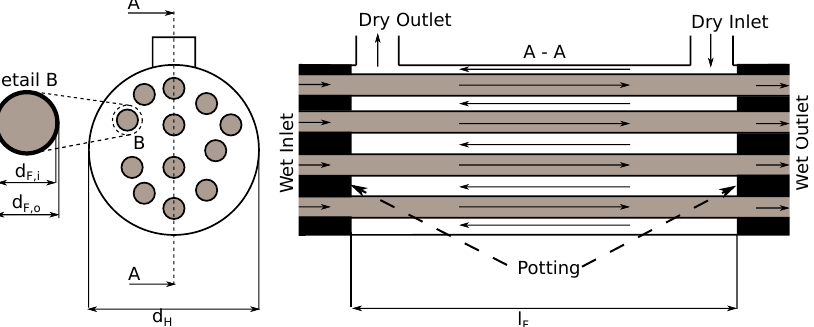
Figure 1. Schematic drawing of the modelled hollow fibre humidifier. The fibres are marked in light grey and the shell side with white background. The flow is arranged in counterflow, as seen in cut view A-A. A detailed view of the fibre is given in